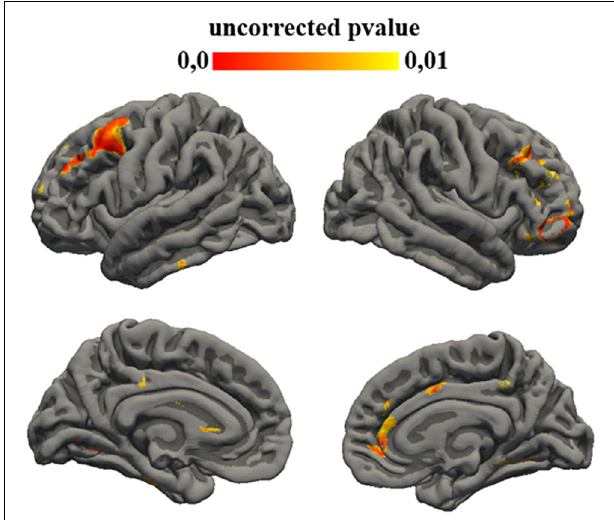
FIGURE 4 | Uncorrected p -value maps for gyrification ADOS-restricted and repetitive behavior score correlation. Significance was set at 0.01.